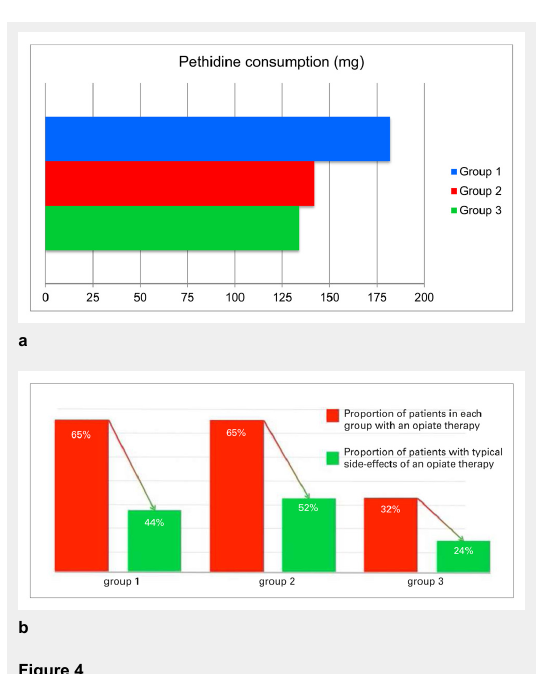
Group differences in pethidine consumption (a) and drop in side effects of opioids per group (b).